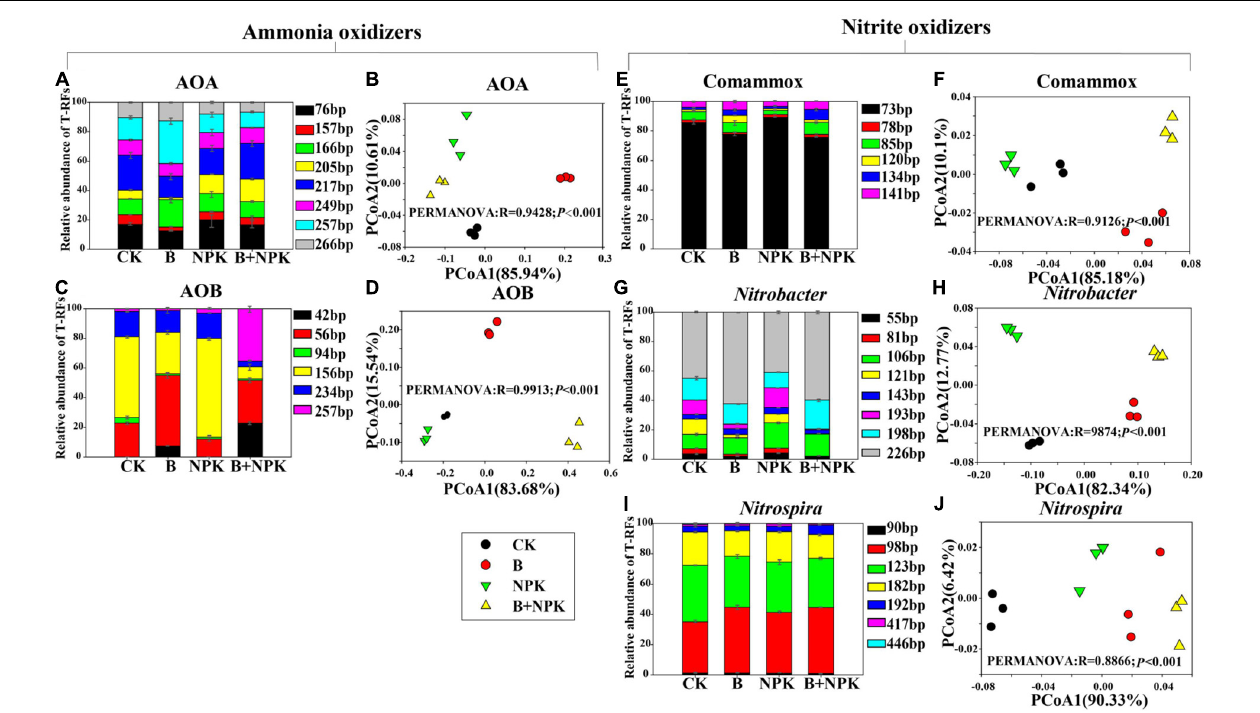
FIGURE 2 | Treatment effects on nitrifying communities in rhizosphere soil characterized by terminal restriction fragment length polymorphism (T-RFLP). The T-RFLP profiles and principal coordinate analysis (PCoA) graphs of ammonia-oxidizing archaea (AOA) amoA (A,B) , ammonia-oxidizing bacteria (AOB) amoA (C,D) , Comammox Nitrospira amoA (E,F) , Nitrobacter -like nxrA (G,H) , and Nitrospira -like nxrB (I,J) genes across treatments. Permutational multivariate analysis of variance (PERMANOVA) was used to test the differences in community structure among the different treatments. Treatments: CK, no fertilizer; B, biochar; NPK, nitrogen, phosphate, and potassium fertilizers; B + NPK, biochar + NPK. OM, soil organic matter; AP, available P; TP, total P; TN, total N; NO 3 − , nitrate-N; NH 4 + ,